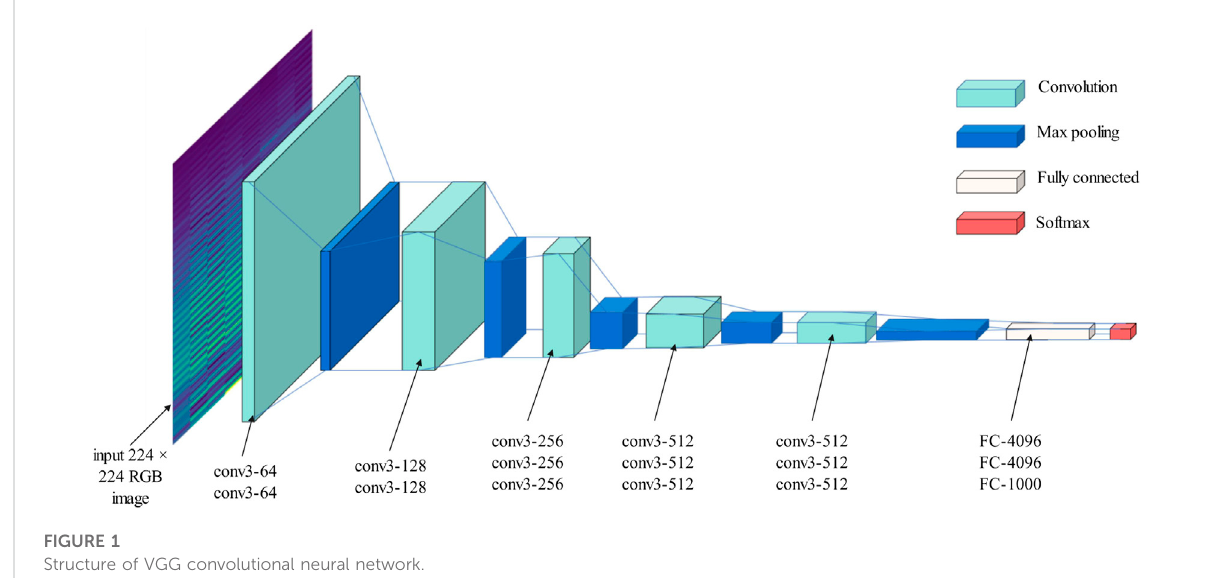
FIGURE 1 Structure of VGG convolutional neural network.